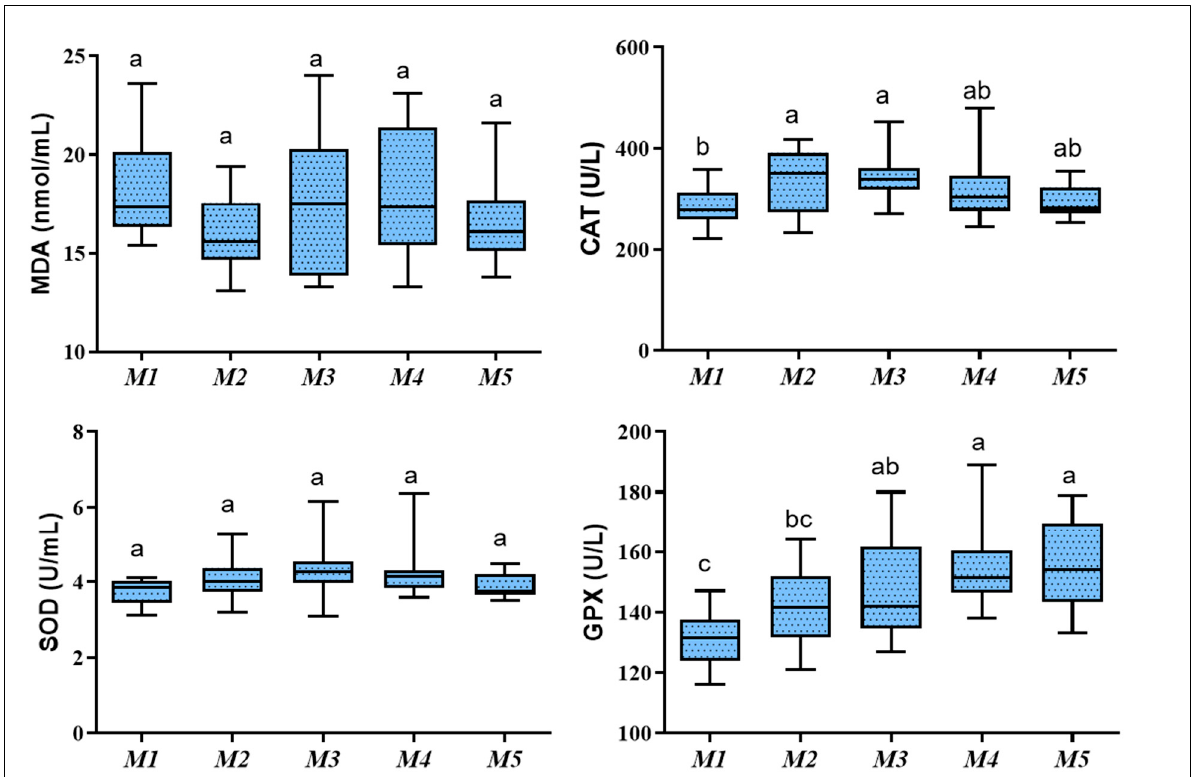
Figure 3. Whisker box plots showing the median and range of plasma level of oxidative stress markers in male Shiba goat’s kids during the first five months of life. Different letters indicate a significant difference between ages per month ( p < 0.05). CAT, catalase; MDA, malondialdehyde; SOD, superoxide dismutase; GPX, glutathione peroxidase.